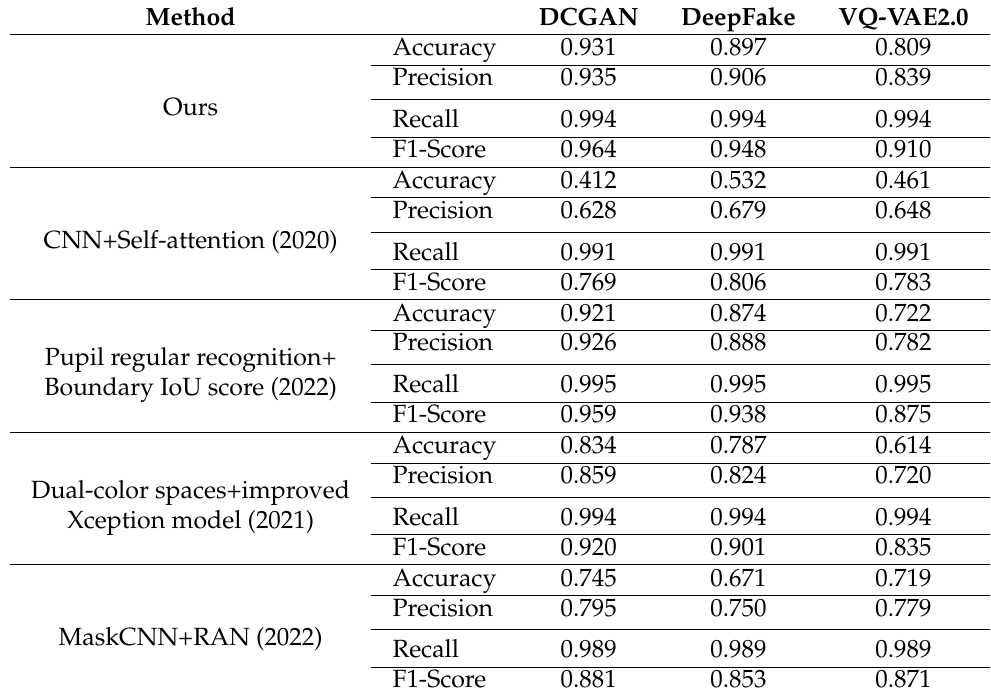
Table 4. Result 2.2: cross domain performance.